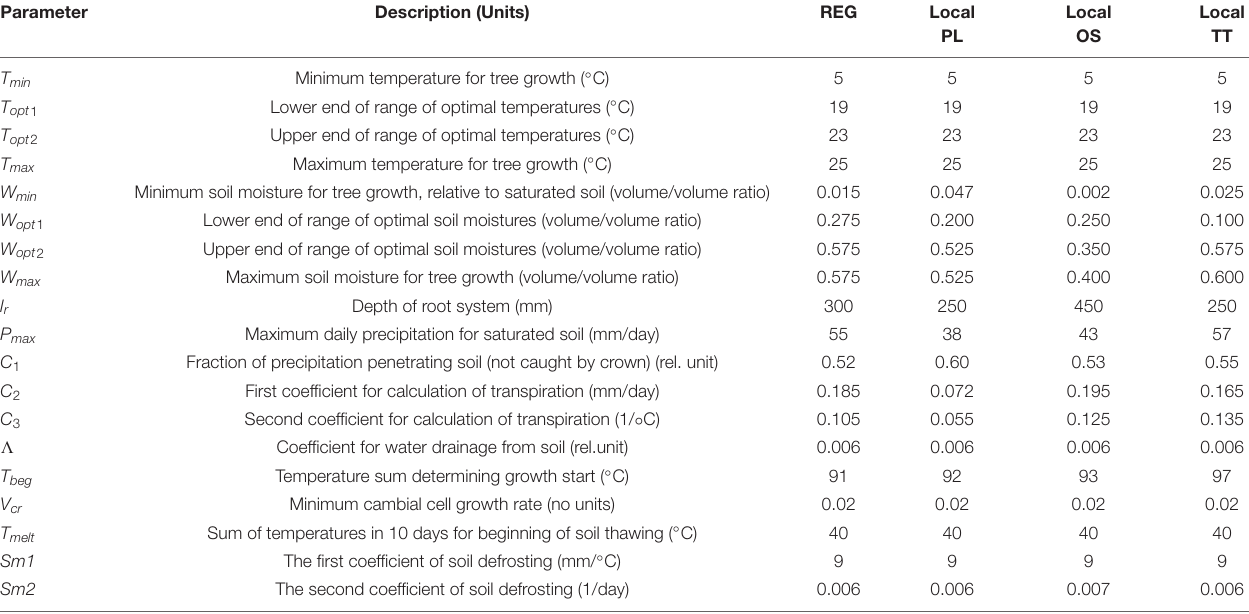
TABLE 3 | Vaganov-Shashkin-model input parameters for the studied period 1971–2011 [for three sites PL, OS, and TT, and for the regional chronology (REG)]. Parameter Description